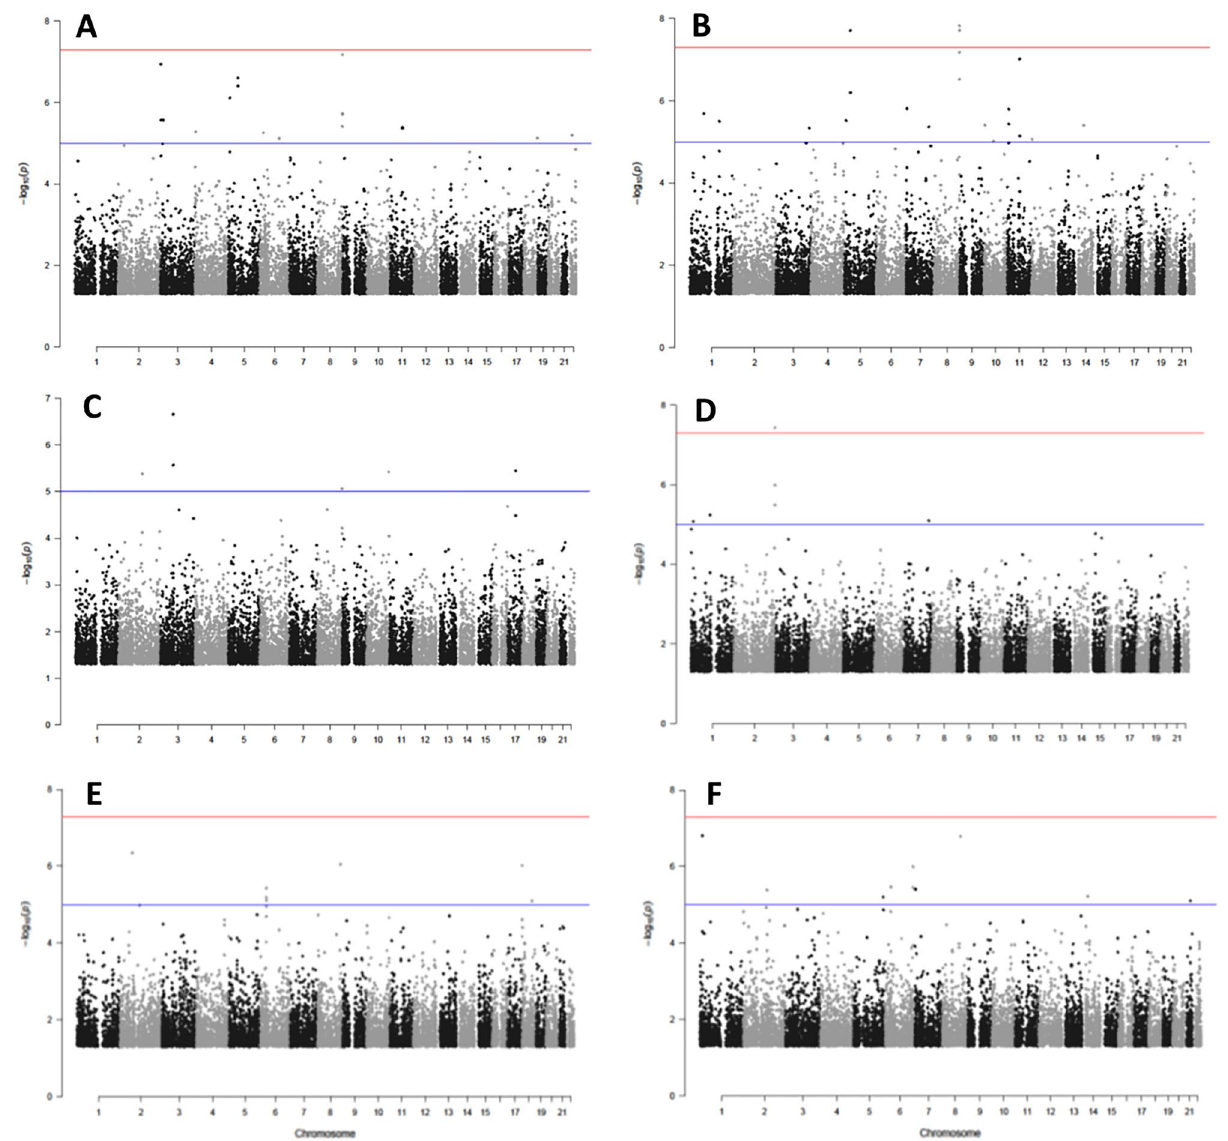
Figure 3. Manhattan plots of OTU-specific mbQTLs. ( A ) Bacteroides V1-V2-V3, ( B ) Bacteroides V4-V5-V6, ( C ) Ruminococcus V4-V5-V6, ( D ) Akkermansia , V4-V5-V6 ( E ) Faecalibacterium and ( F ) Gemmiger V4-V5-V6. Red horizontal line, threshold for genome-wide significance ( P = 5.0 × 10 –8 ). Blue horizontal line, FDR =